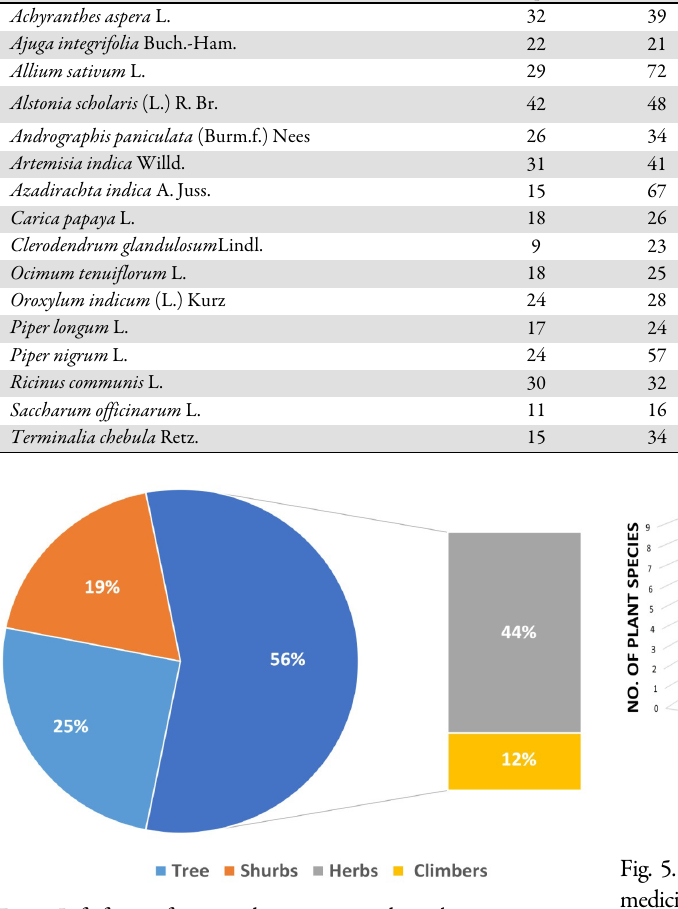
Fig. 3. Life form of reported common medicinal species